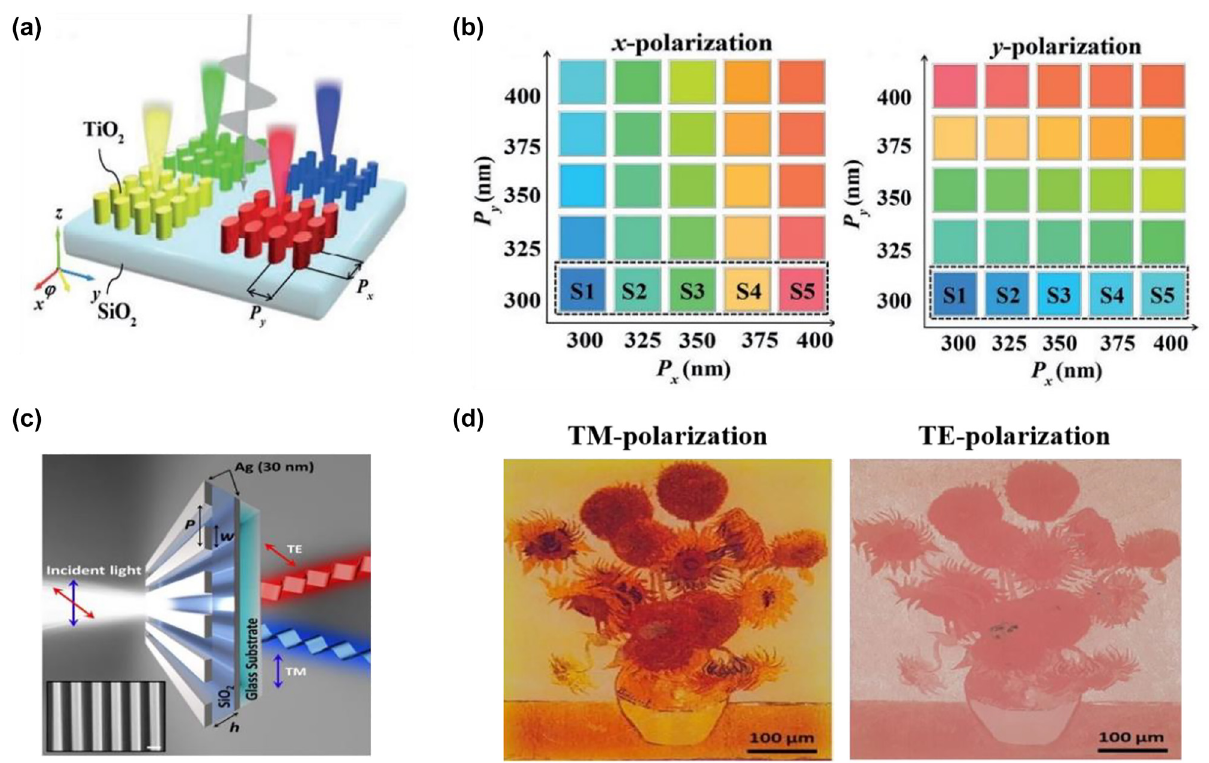
Figure 27: Dynamic structural color generation based on state of polarization of the incident light. (a) Schematic illustration of a polarization-dependent structural color device composed of arrays of TiO elliptic nanopillars on a silica substrate. Periods along the x - and 2 and P , respectively. (b) Color palettes under x - and y -polarized incidence with P and P varying from 300 nm to 400 nm. y -directions are denoted as P x y x y The nanopillar height is fixed as 300 nm and the filling ratios along the two axes are fixed as 0.6. Modified with permission [268]. Copyright 2018, dielectric Wiley-VCH. (c) Schematic of a polarization-selective color device, which is composed of an Ag mirror, a 1D Ag nano-grating layer, and a SiO 2 layer in between. TM polarization refers to electric field vector oscillating orthogonal to the grating direction, while TE polarization refers to electric field along the grating direction. (d) Optical images of a fabricated sample (showing Vincent van Gogh’s Sunflower) under TM- and TE-polarized illumination. Modified with permission [271]. Copyright 2020, American Chemical